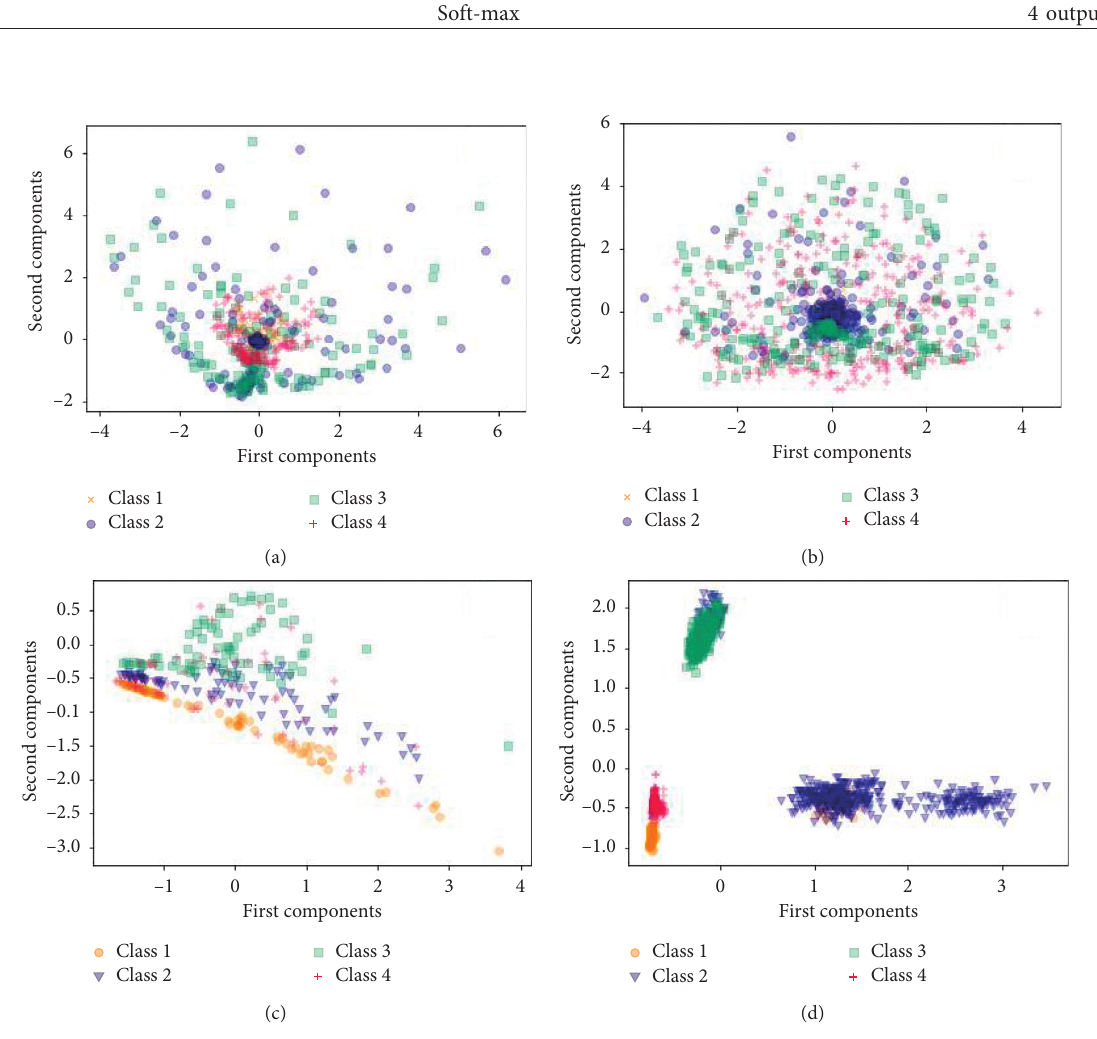
Figure 7: The output graph of principal component analysis (PCA) method. (a) Input data at a single rotation speed; (b) input data after data level fusion; (c) input data extracted by manual features; (d) adaptive feature learned through DCNN. Table 5: The comparison test results of several network